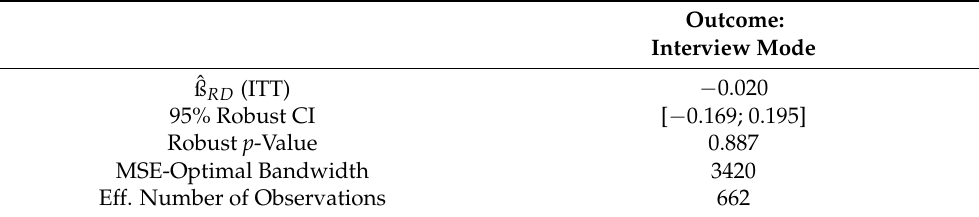
Table 5. RD effect with placebo outcome variable interview mode.